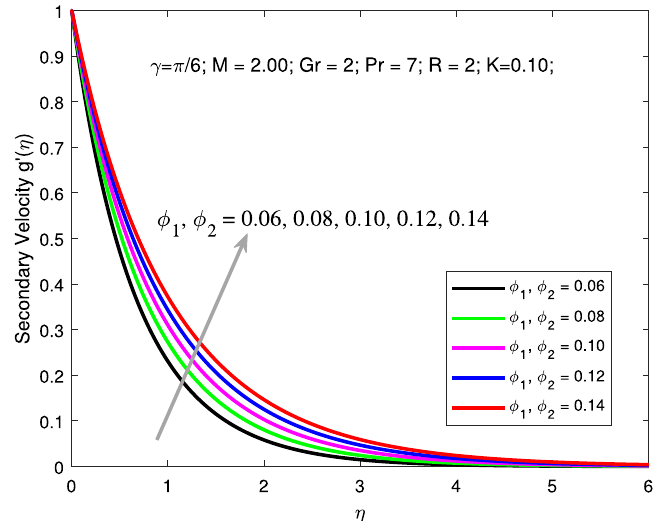
Figure 7. Variation of secondary velocity with nanoparticle volume fraction.